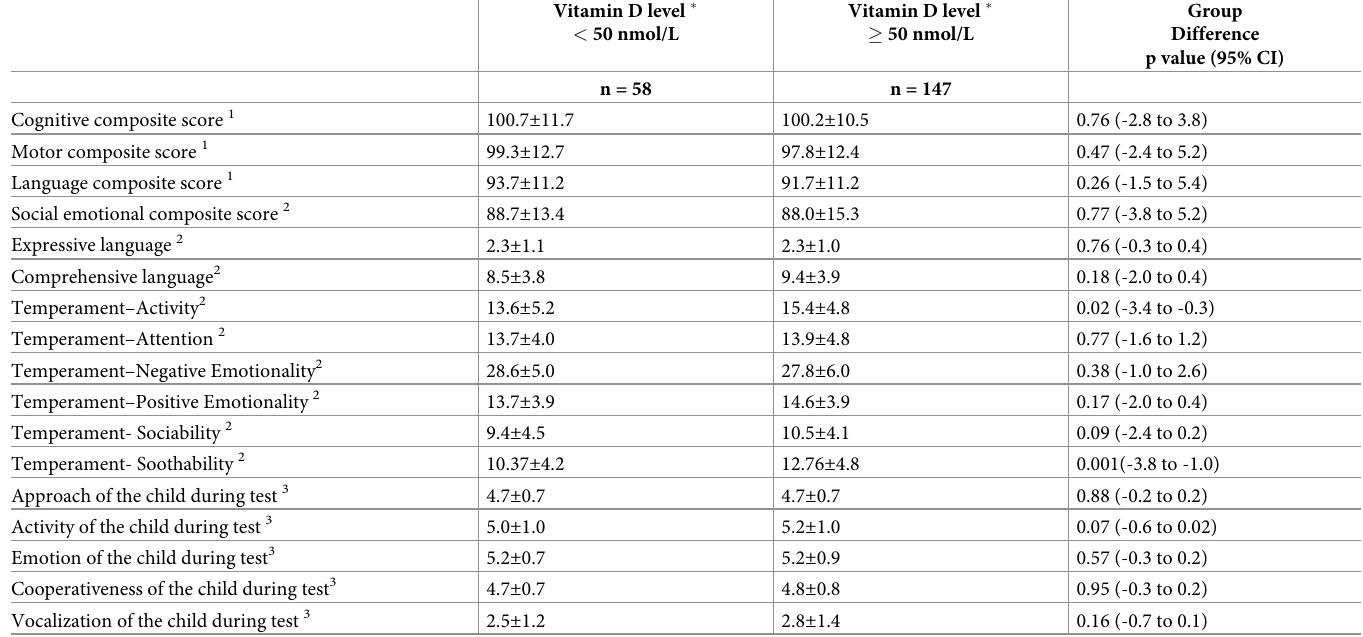
Table 3. Distribution of cognitive, motor, language, temperament and behavioral scores of children by vitamin D deficient ( < 50 nmol/L) and sufficient ( � 50 nmol/L) group (unadjusted